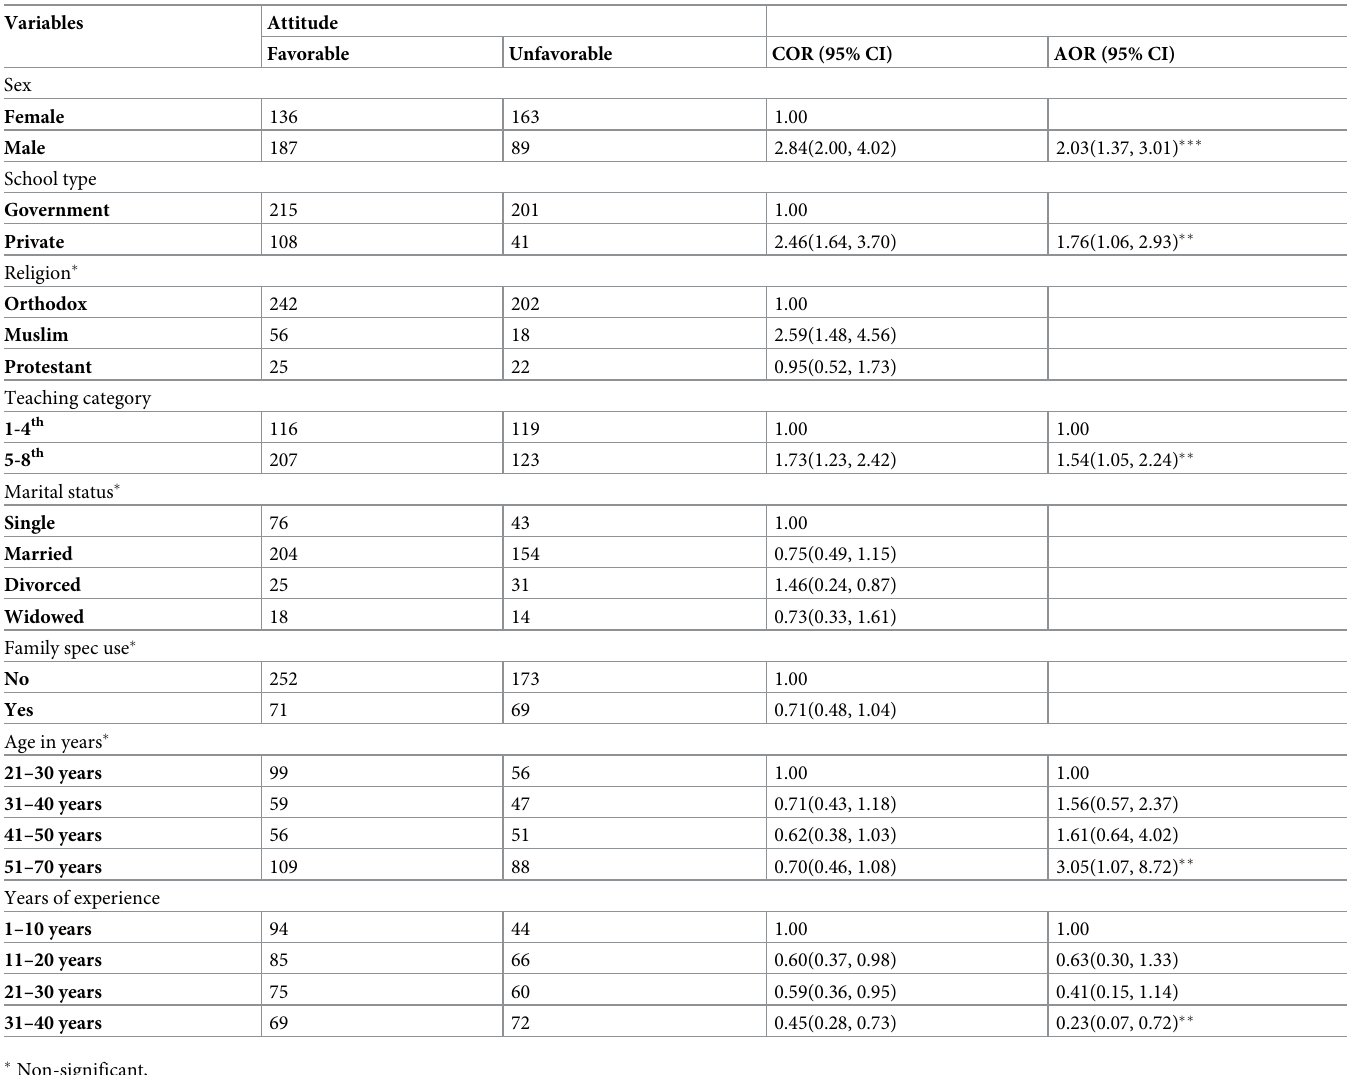
Table 4. Factors associated with attitude among primary school teachers regarding refractive error in school children in Gondar town, Northwest Ethiopia, 2017.